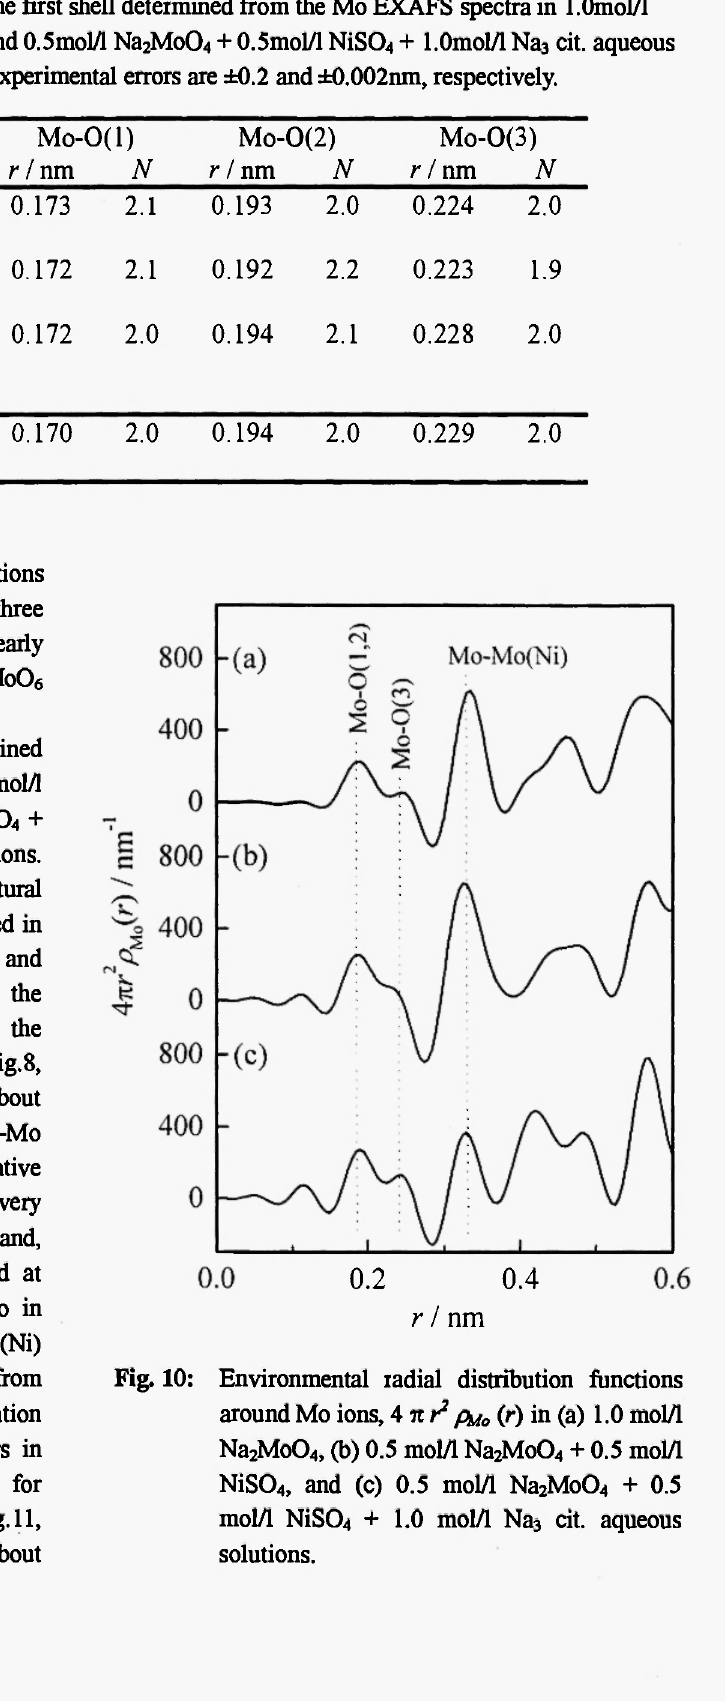
Mo0 + 0.5mol/l NiS0 2 4